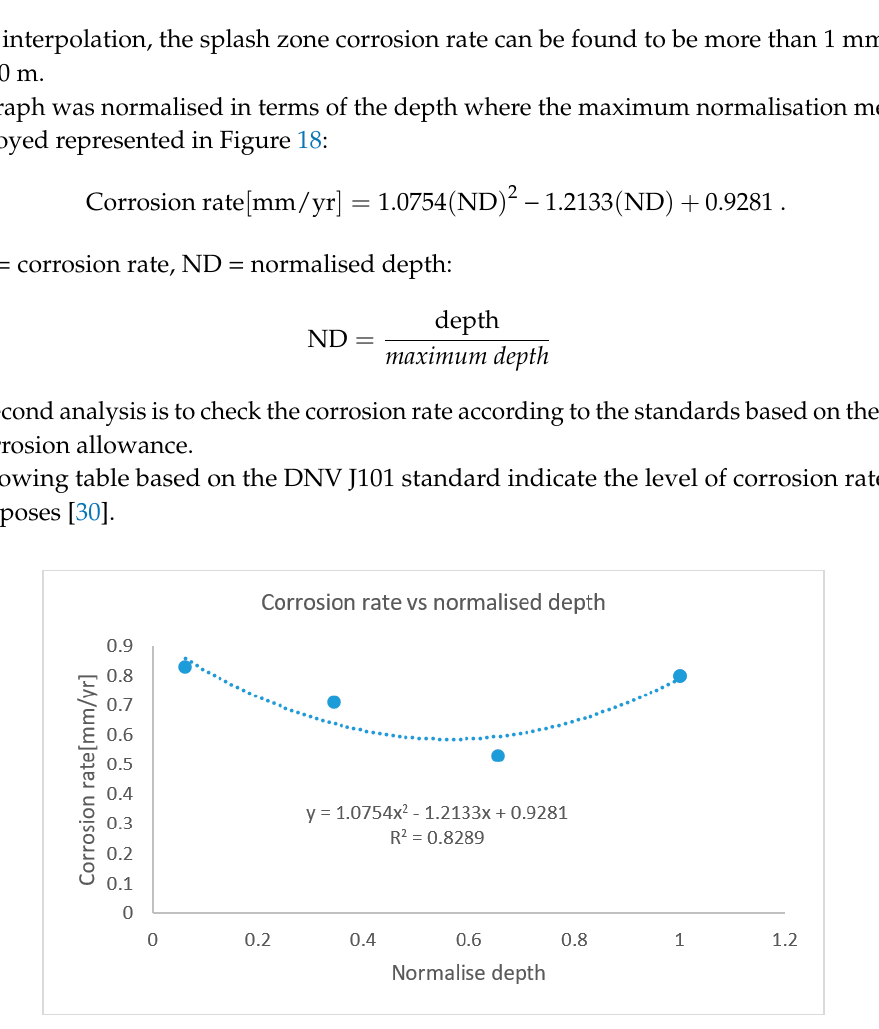
Table 3. Standard corrosion rates for di ff erent